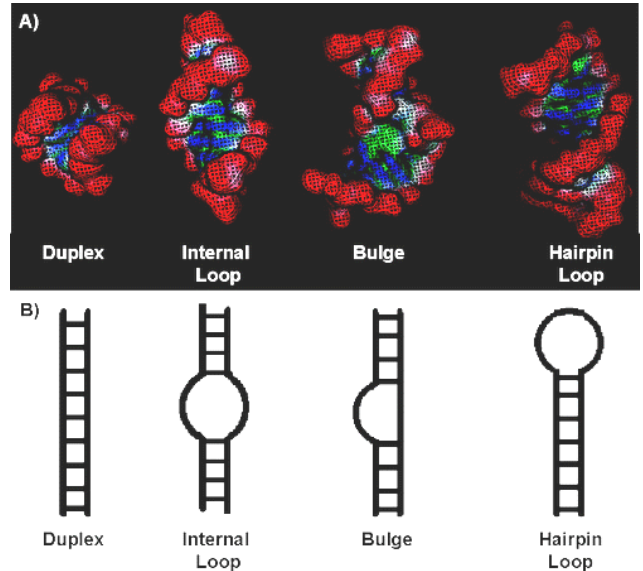
Figure 13. Four general classes of RNA secondary structure. ( A ) Surface representations of individual secondary structures. ( B ) Schematic representation of RNA duplex, internal loop, bulge, and hairpin loop (also called stem loop) regions of RNA [82].